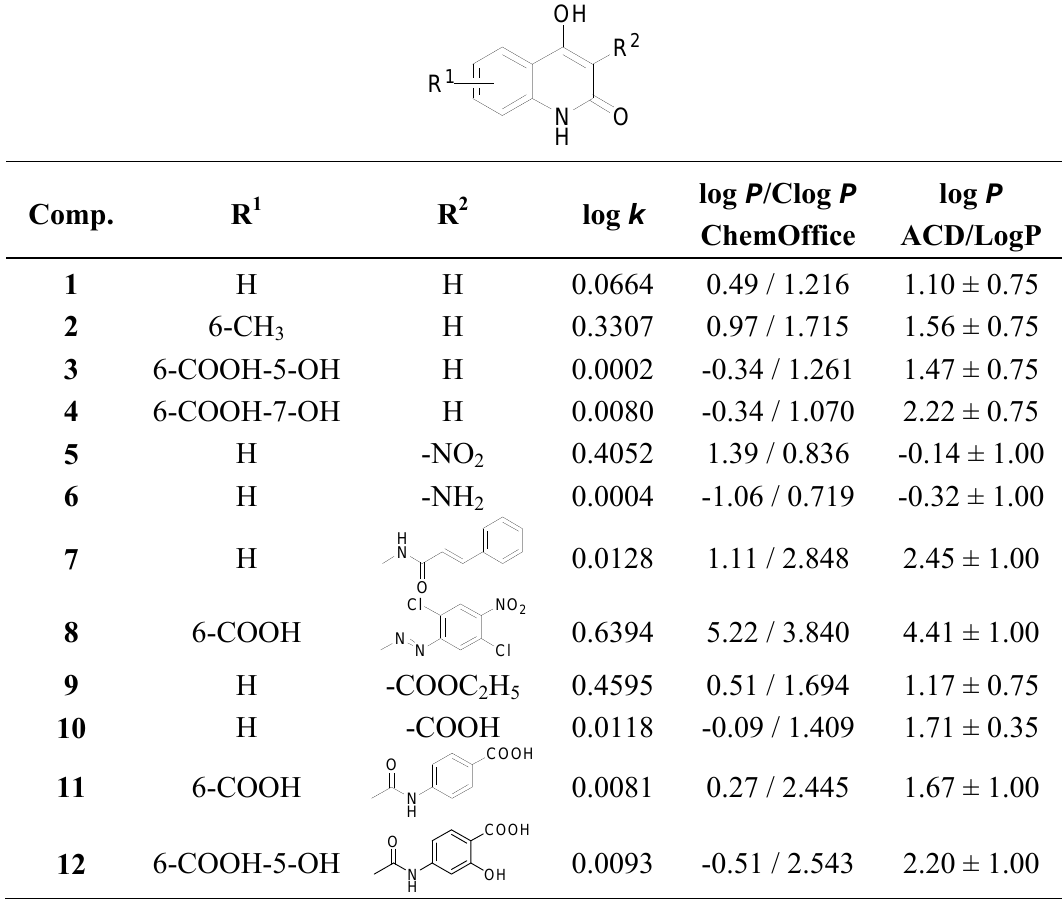
Table 1. Comparison of the calculated lipophilicities (log P /Clog P ) with the determined log k